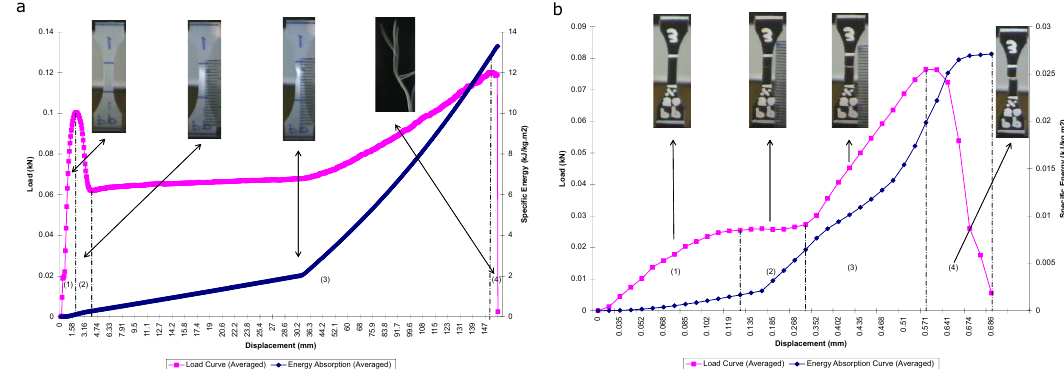
Figure 4. Load and energy absorption versus displacement: ( a ) PP-100% and ( b ) PP-50%/COTTON